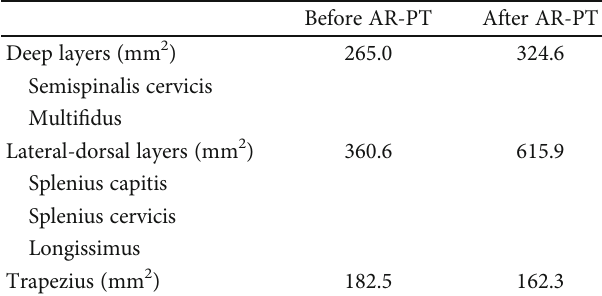
Figure 2: T2-weighted magnetic resonance (MR) sagittal image (a) and axial image at C5-C6 (b) of the patient ’ s cervical spine at the fi rst visit. (a) Cervical alignment was slightly kyphotic, and the C5-C6 intervertebral disc protruded posteriorly (arrow). (b) The cervical extensor muscles were atrophic. The trapezius muscles showed a stretched morphology (arrowhead). ➀➁ : deep layers of the cervical extensor muscles (semispinalis cervicis and multi fi dus). ➂➃ : lateral-dorsal layers of the cervical extensor muscles (splenius capitis, splenius cervicis, and longissimus). ➄➅ : trapezius. ➆ : C5-C6 disc. Table 1: Cross-sectional area of the cervical extensor muscles and trapezius at the C5-C6